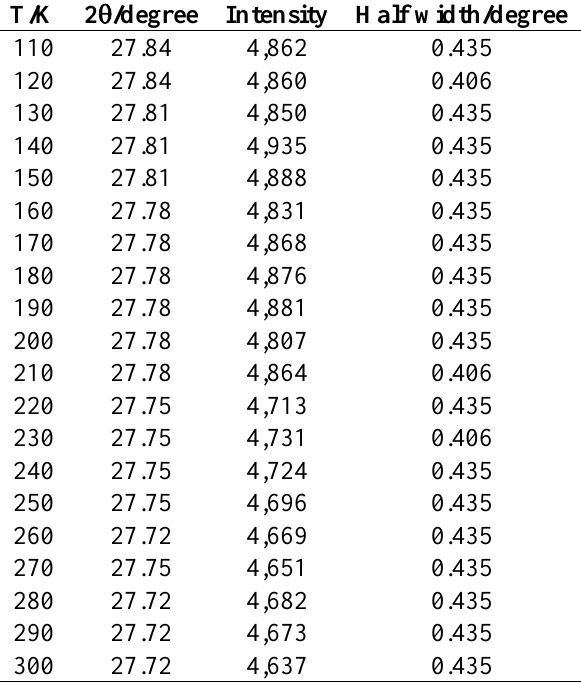
Table 1. Thermal shift features of the most intense peaks.